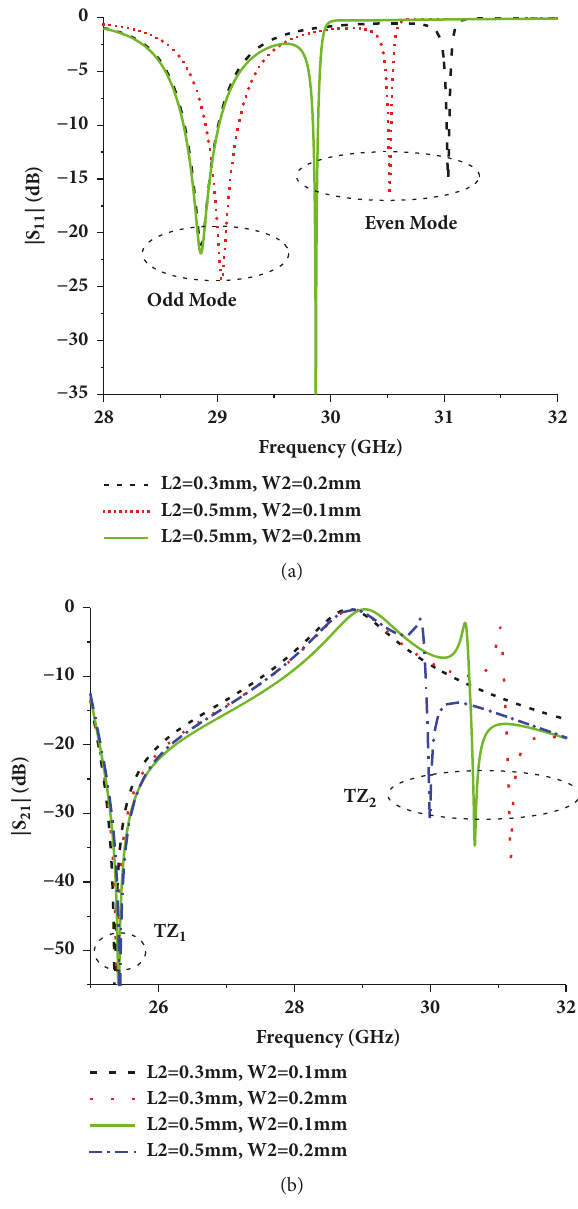
Figure 2: Simulated frequency responses of the dual-mode open-loop resonator with different size of L 2 and W 2 (mm): (a) S 11 responses; (b) S 21